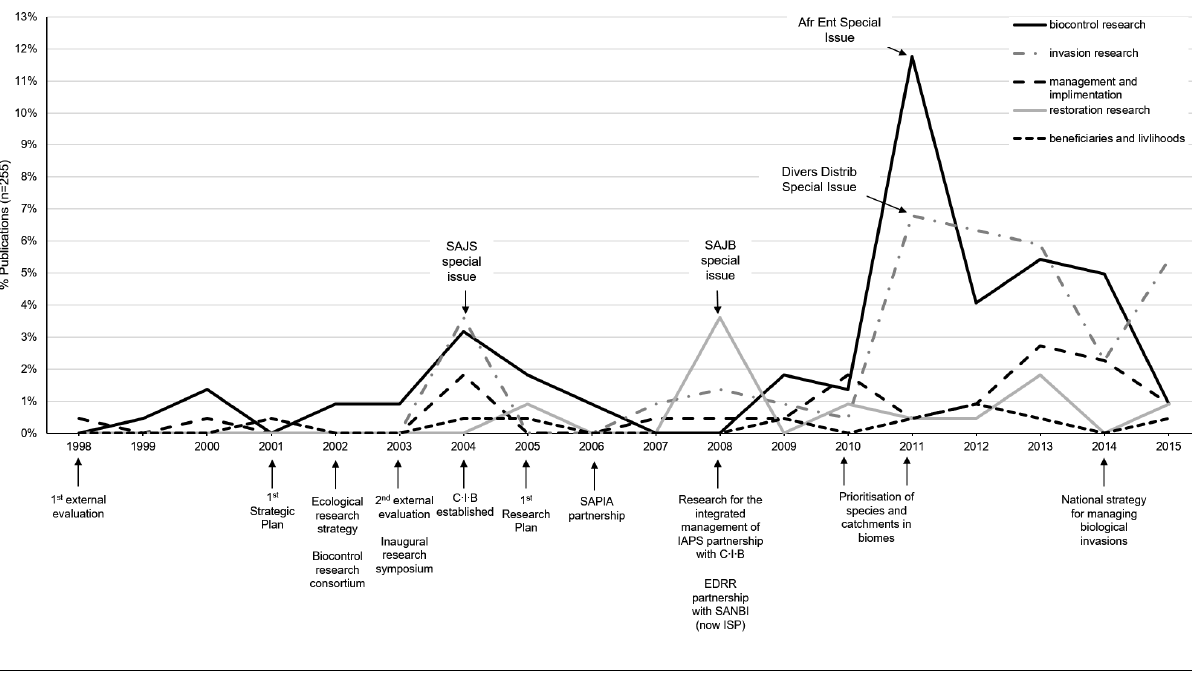
Research Article https://doi.org/10.17159/sajs.2019/4263